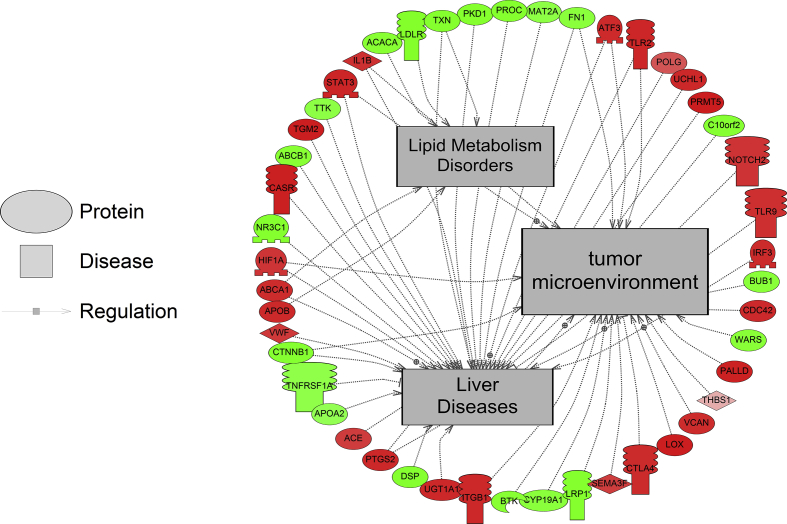
Protein network for lipid metabolism disorders, tumor microenvironment and liver disease following high dose treatment of dieldrin in the zebrafish liver. Protein data were generated using label-free proteomics. Red indicates that protein levels are increased for that protein and green indicates that the protein levels are decreased relative to the control group. The more intense the color, the larger the relative fold change of the protein compared to the control group. Circles indicate proteins, mushroom shaped entities with notches along the side represent receptors, while mushroom-shaped entities with notches on the bottom refer to transcription factors. Abbreviations are provided in Supplemental Data 4.